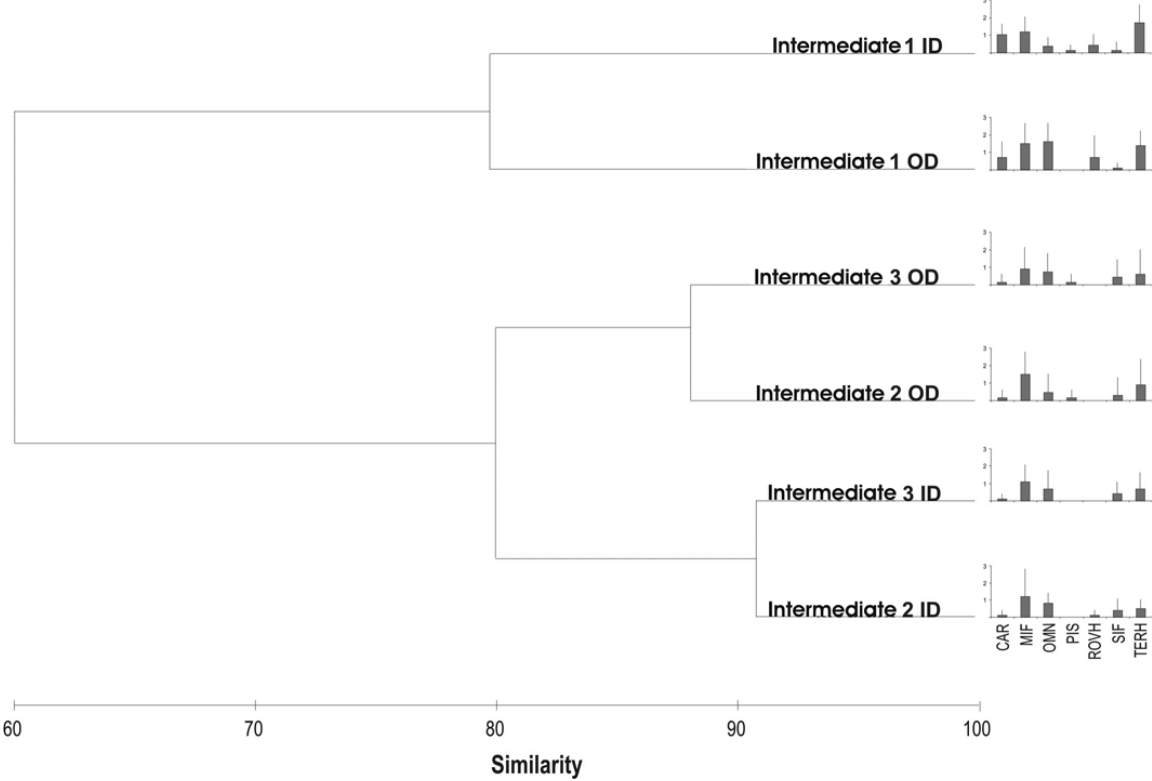
Fig. 9 – Similarity cluster analysis of trophic guilds among OD and ID patches on intermediate zones of Maramutá reefs. CAR = carnivore; MIF = Microinvertebrate feeder; OMN = Omnivore; PIS = Piscivore; ROVH = Roving Herbivore; SIF = Sessile Invertebrate feeder; TERH = Territorial